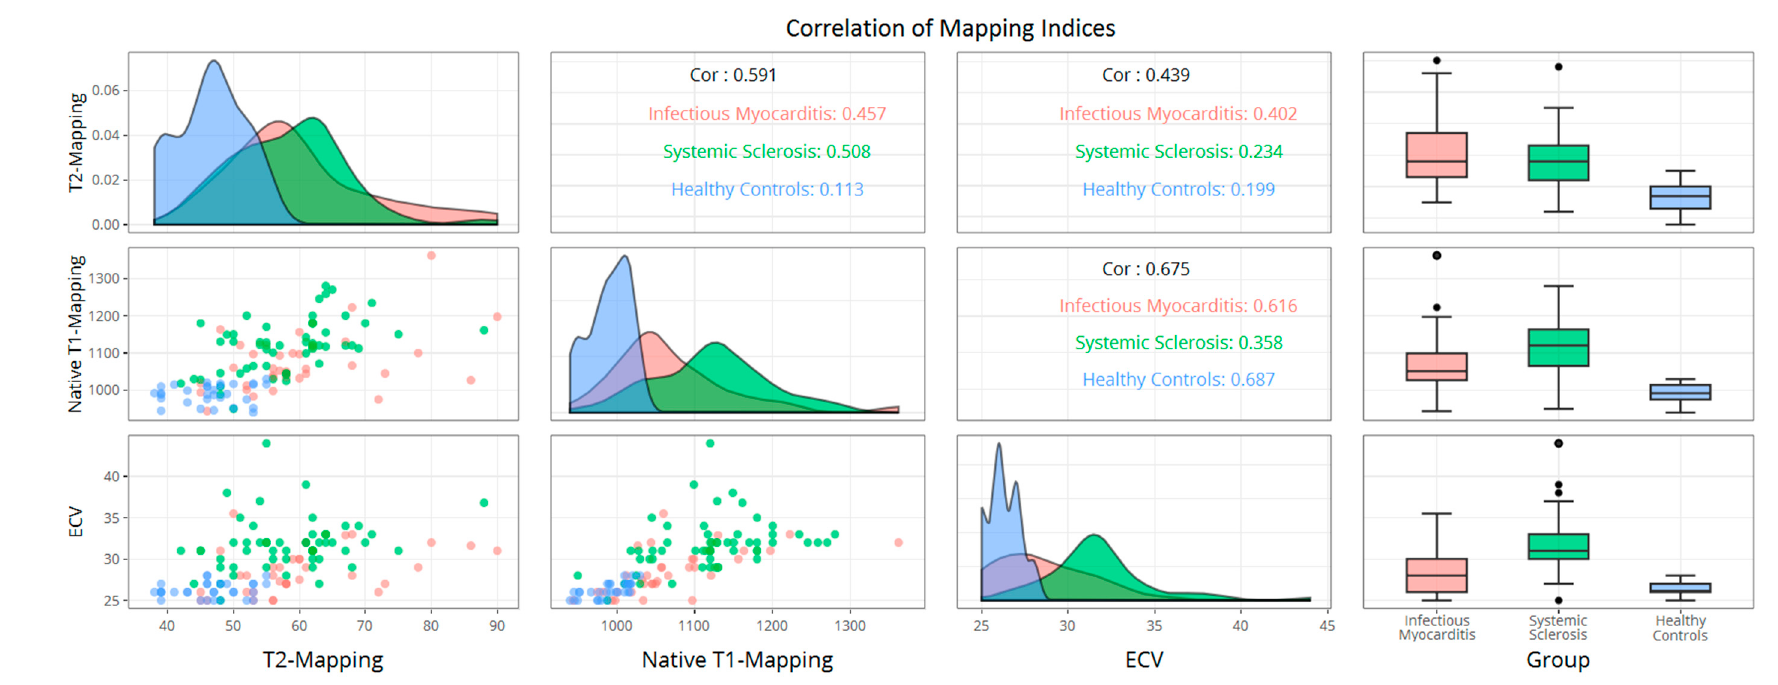
Figure 2. Two-dimensional scatterplots and boxplots for native T1-mapping, T2-mapping and ECV with individuals color coded according to the study group they belonged to. Spearman’s correlation coefficients are presented for each combination of the three indices collectively and for each group separately. The distribution of each variable per group is also presented as a density plot. ECV: extracellular volume fraction.